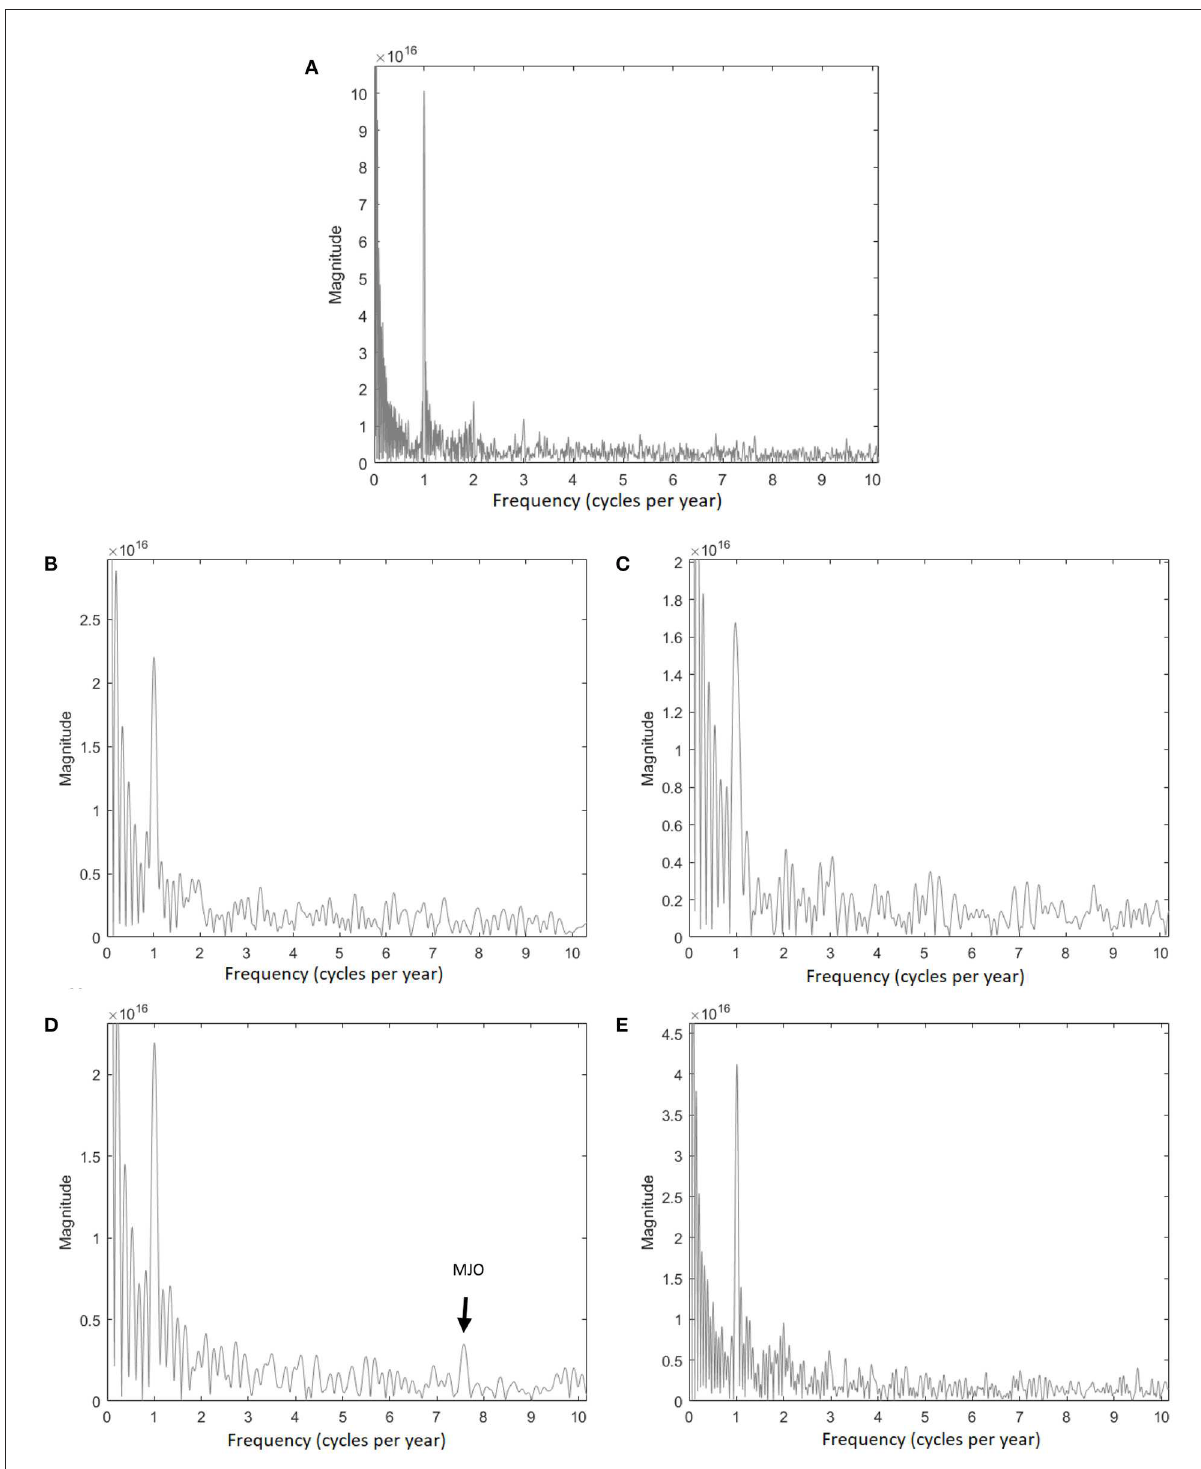
FIGURE2 Magnitudes of the power spectra of the daily NHCPV area over (A) 1979–2017, (B) 1979–1986, (C) 1986–1994, (D) 1994–2001, and (E) 2001–2017 periods. The peaks indicate the magnitude of the high-frequency variability. The highest peaks at 1 cycle year − 1 indicate an annual cycle for all